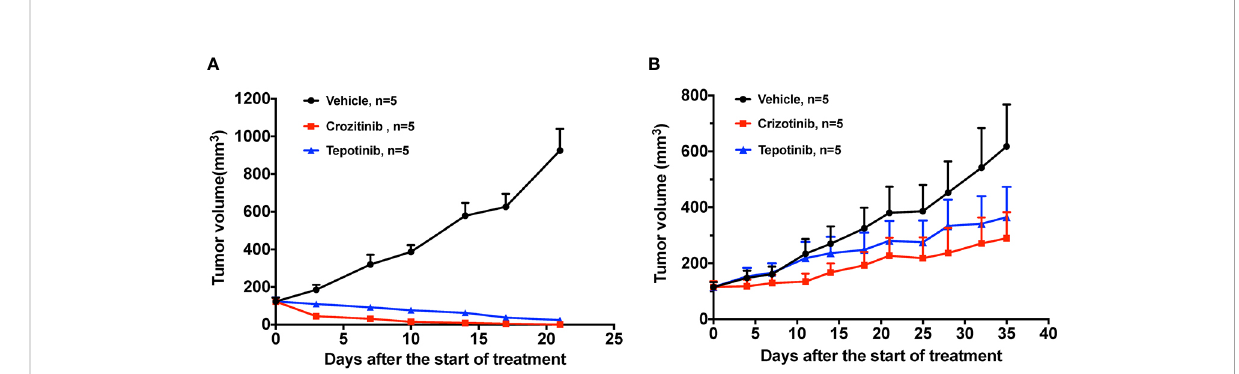
FIGURE 3 The effect of TKIs on two PDX models. (A) Tumor change in pretreatment PDX mice treated with vehicle, 50 mg/kg crizotinib and 10 mg/kg tepotinib once a day for 3 weeks. (B) Tumor change in drug resistant PDX mice treated with vehicle, 50 mg/kg crizotinib and 10 mg/kg tepotinib once a day for 5 weeks. Tumor volume was measured and expressed as the mean ± standard